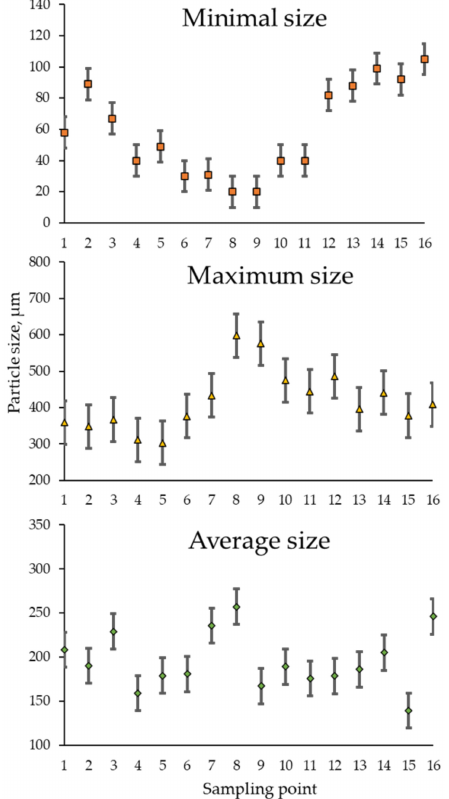
Figure 5. Particle sizes depending on the sampling